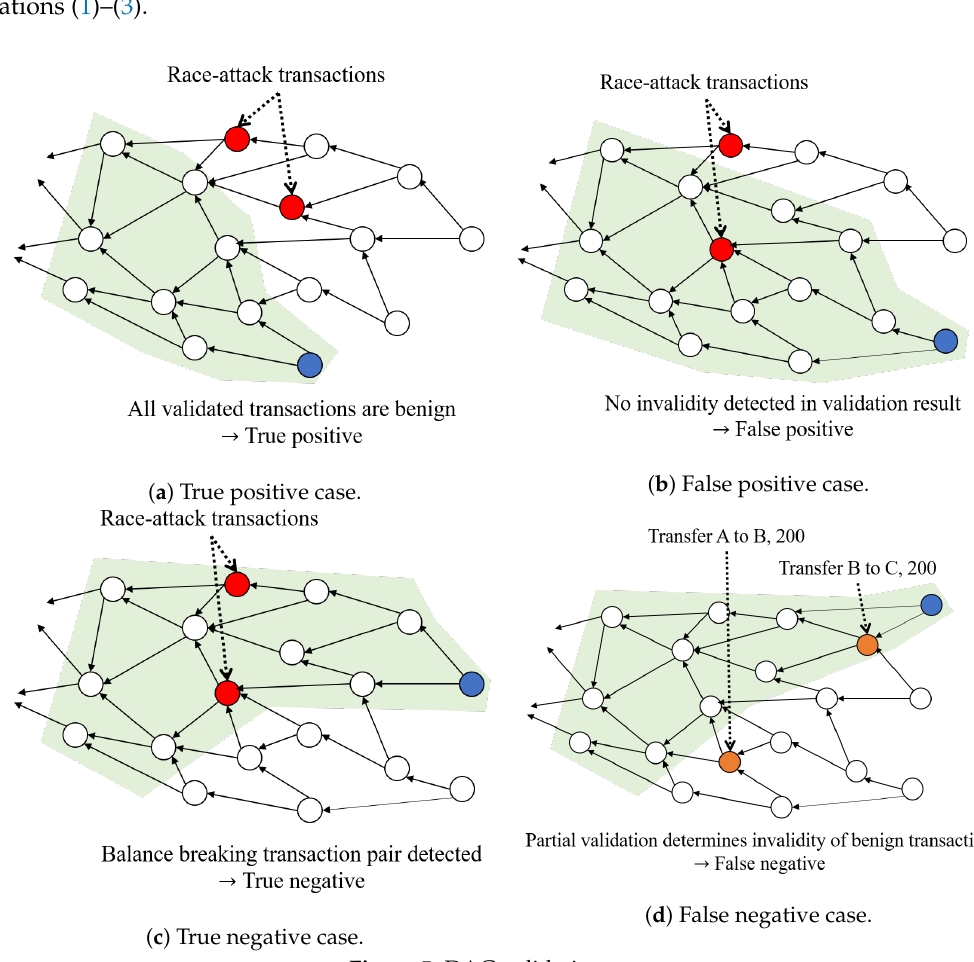
Figure 5. DAG validation